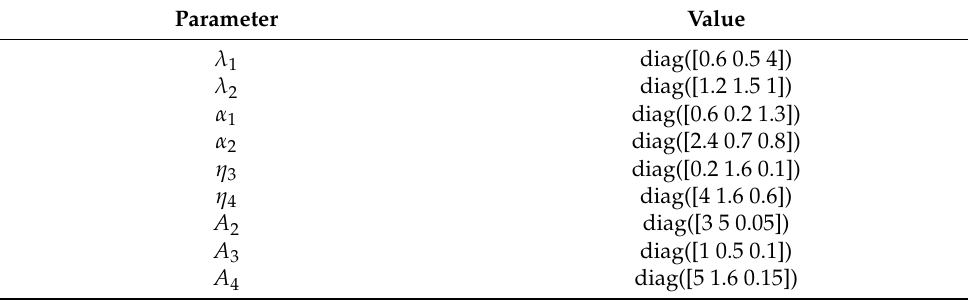
Table 3. The parameters of the